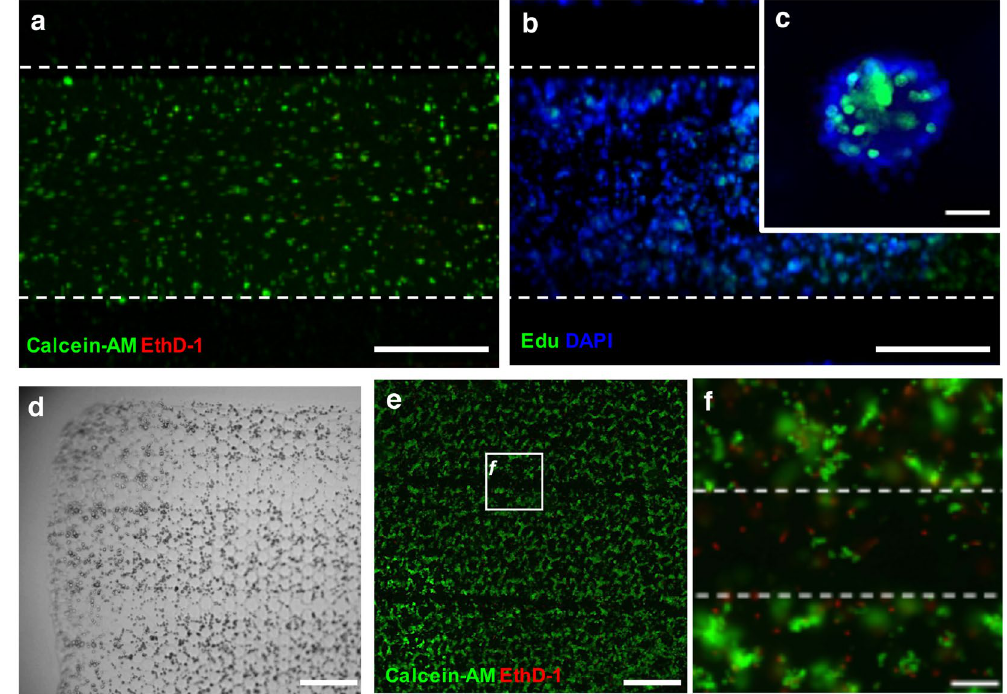
Figure 4. Maintenance of encapsulated cells in the modular sheet inside/outside of the microfluidic assembly platform. Encapsulated MIN6 cells in the modular hydrogel sheet under the microfluidic assembly platform were assessed for their viability ( a , live (calcein-AM) and dead cells (EthD-1, ethidium homodimer-1) on day 3) and proliferation ( b,c , replicated nuclei (EdU, 5-ethynyl-2 ′ -deoxyuridine) and nuclei (DAPI) on day 14) under the microfluidic assembly platform for 1 h. ( a , b ) The dotted line indicates a boundary of the incubating chamber in the PDMS chip. ( d – f ) The pressed modular sheet was obtained ( d ) and the viability of the encapsulated MIN6 cells were also assessed ( e ). Scale bar = 500 µ m. ( f ) The dotted line indicates a boundary of the microchannel wall in the PDMS chip. ( f ) Shows an enlarged image, as indicated by the box in panel e. Scale bar = 100 µ